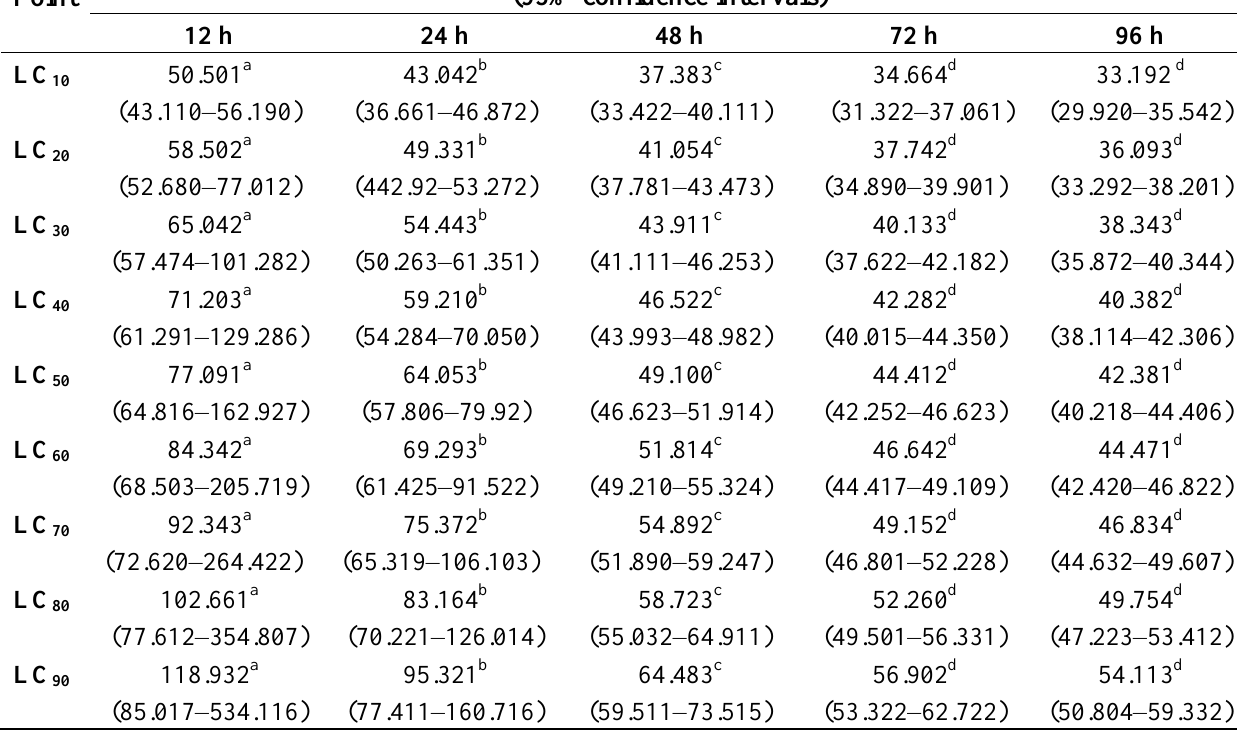
Table 2. Lethal concentrations (LC for C . punctatus.